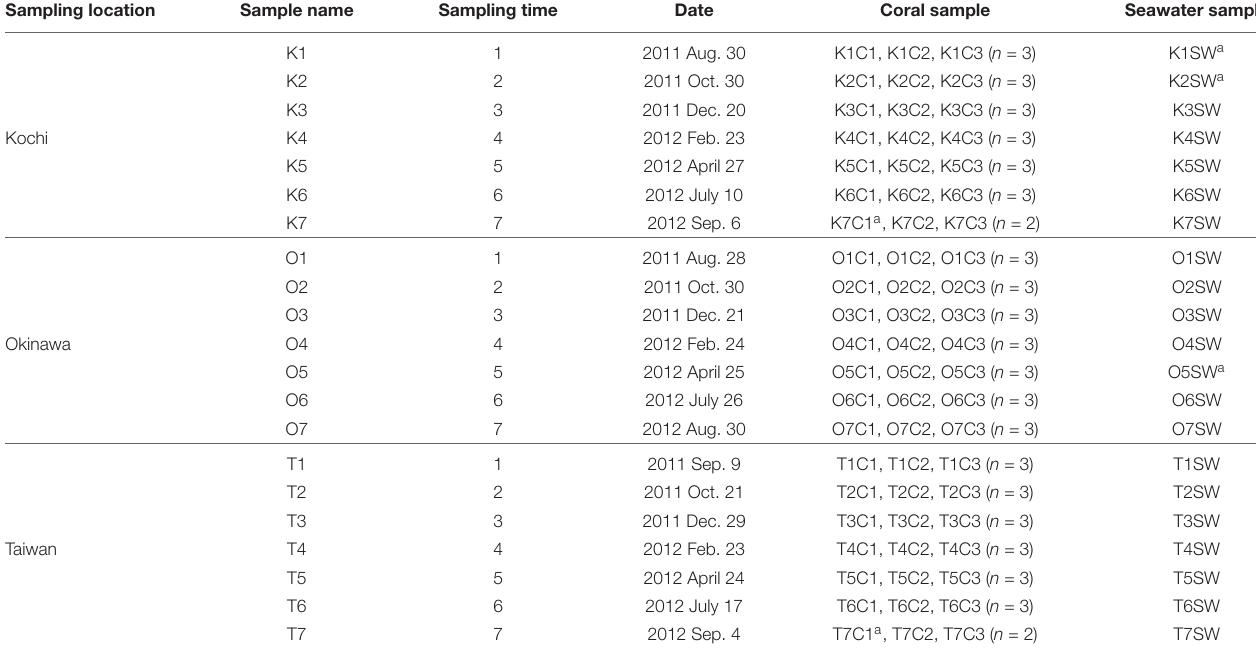
TABLE 1 | Sampling information and sample identifier of Acropora muricata and